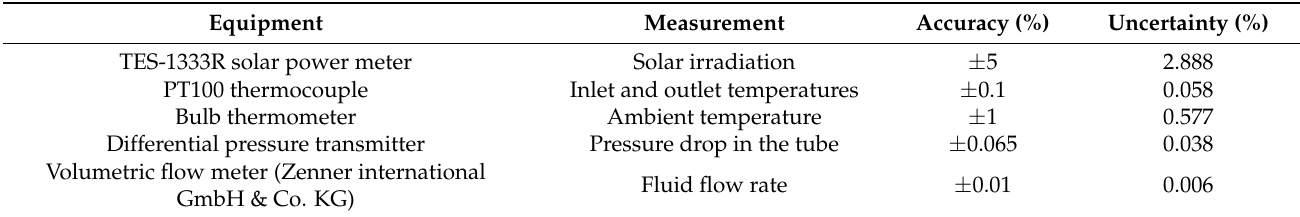
Table 2. The list of equipment for measurement and their accuracy.